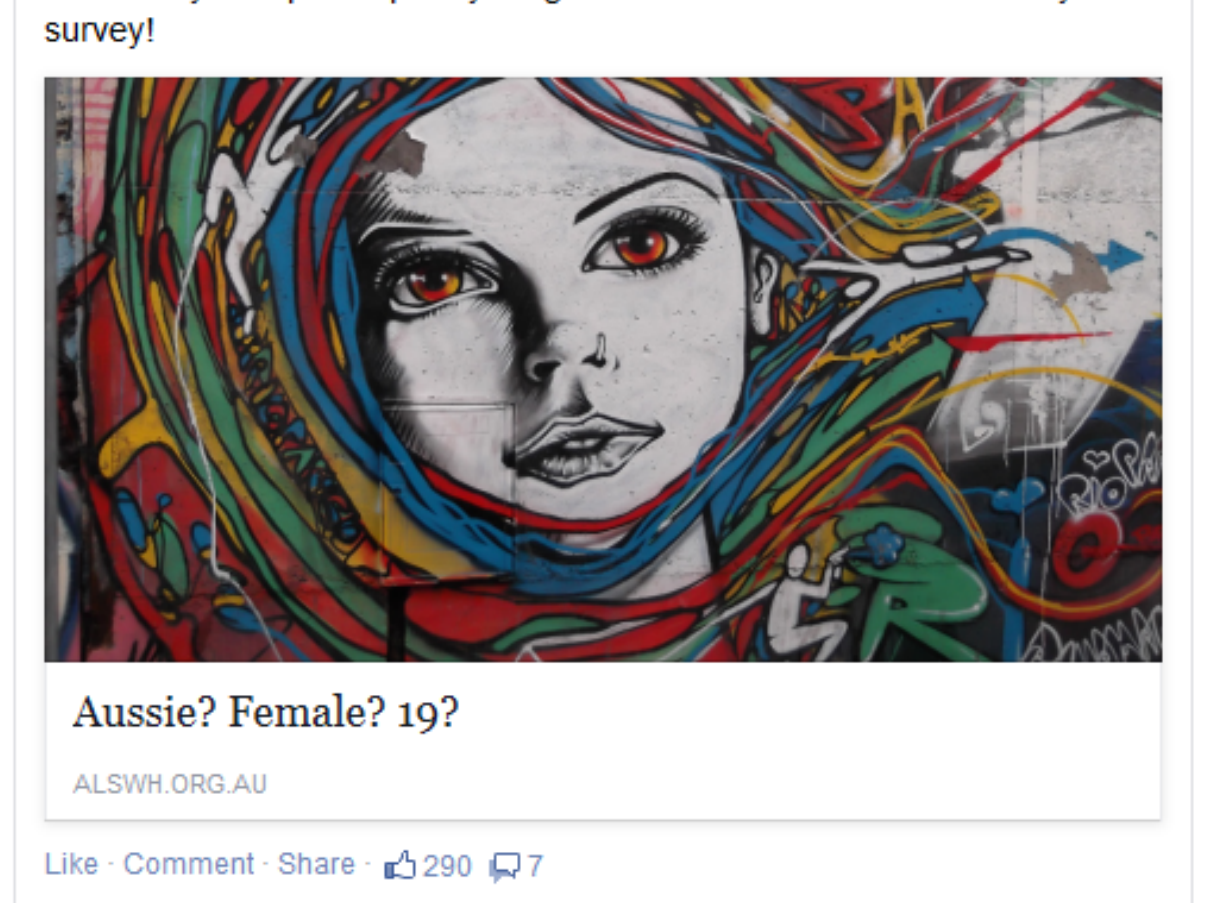
Figure 3. A successful Facebook advertisement created as part of the ALSWH promotion, targeted at women living in Australia aged 19 (7669